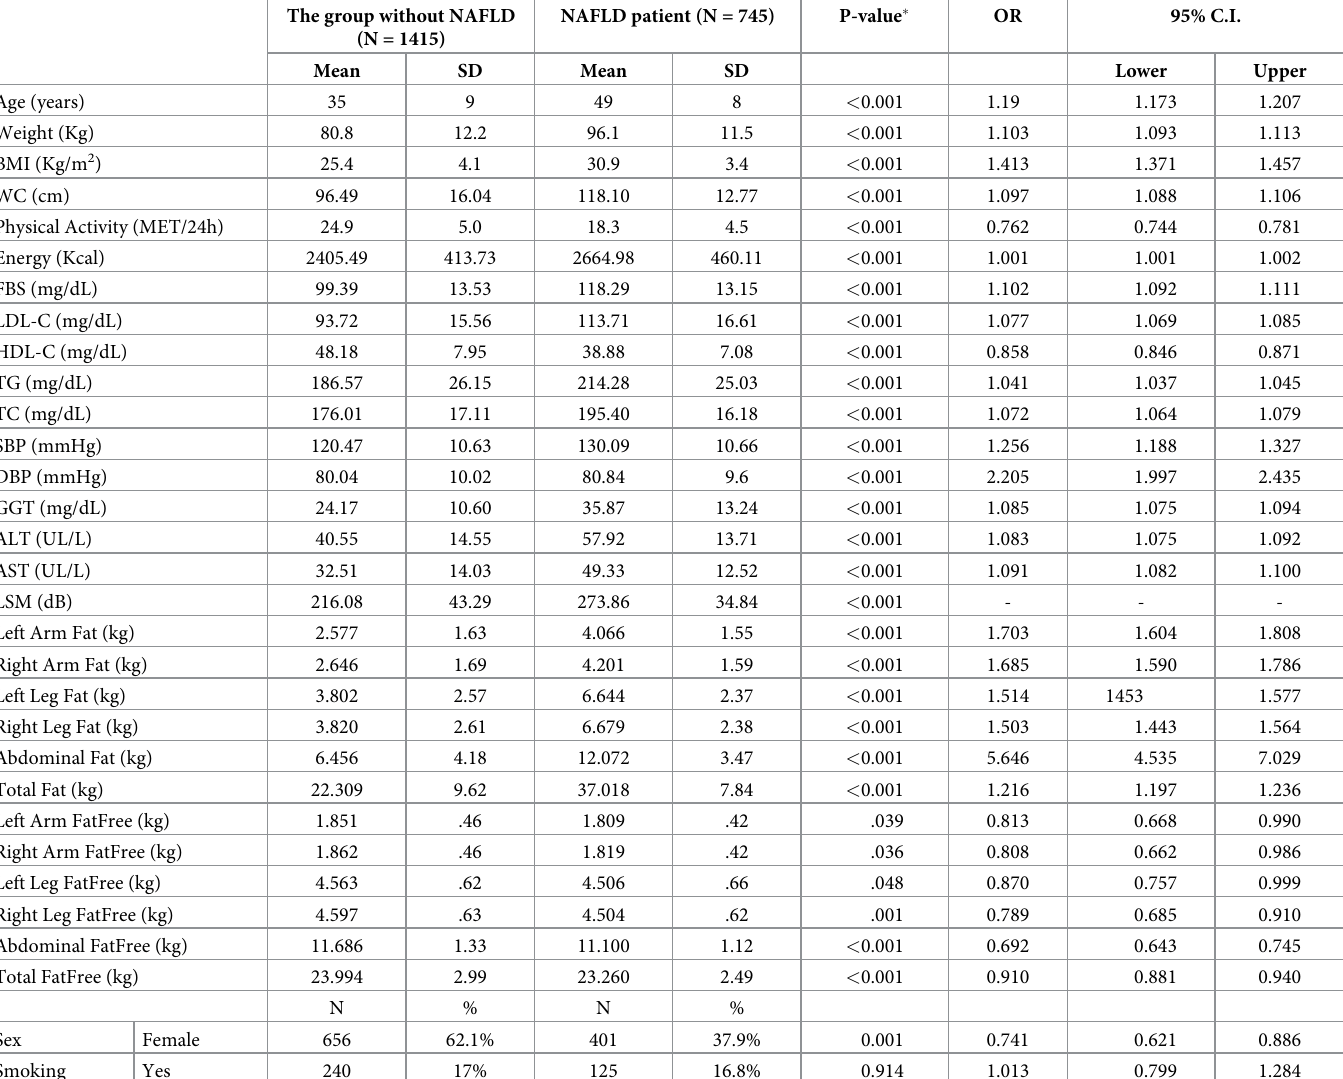
Table 1. Demographic and basic information of the participants in the group without NAFLD and NAFLD patients. The group without NAFLD (N =